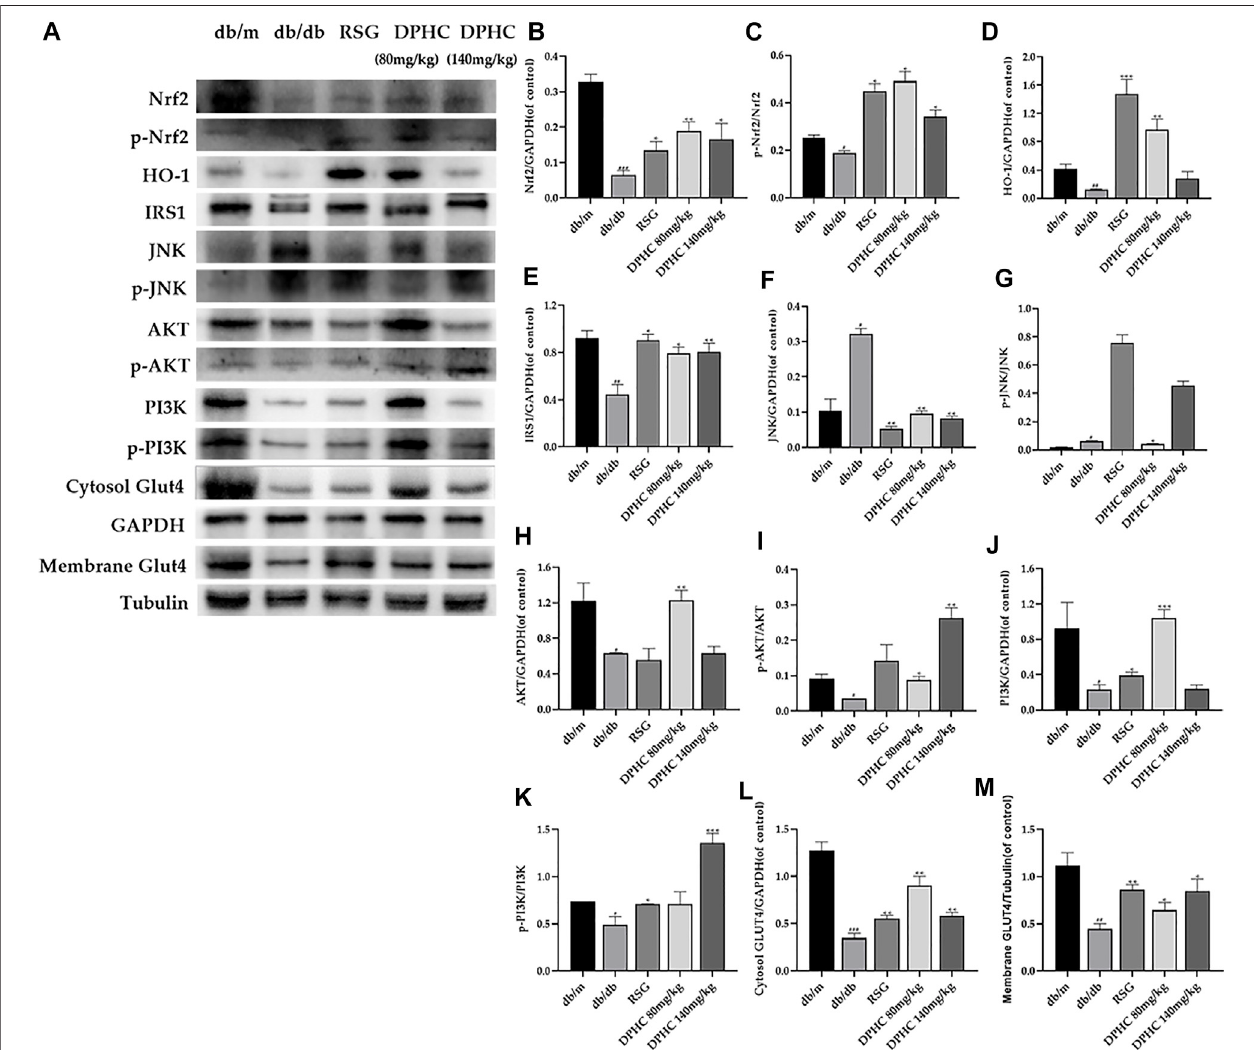
FIGURE6| EffectsofDPHConameliorating oxidative stressandIR via Nrf2/AREsignalpathway-relatedproteinsinlivertissues ofdb/db mice. (A) Theexpression levels of Nrf2, p -Nrf2, HO-1, JNK, p -JNK, IRS1, AKT, p -AKT, PI3K, p-PI3K, cytosol GLUT4, and membrane GLUT4 in liver tissues of mice. (B) Nrf2. (C) The ratio of p -Nrf2/Nrf2. (D) HO-1. (E) IRS1. (F) JNK. (G) Theratioof p -JNK/JNK. (H) AKT. (I) Theratioof p -AKT/AKT. (J) PI3K. (K) Theratioofp-PI3K/PI3K. (L) CytosolGLUT4. (M) Membrane GLUT4. All values are expressed as means ± SD, n (cid:1) 3. * p < 0.05, ** p < 0.01, *** p < 0.001 compared with the db/db group, and # p < 0.05, ## p < 0.01, ### p < 0.001 compared with the db/m